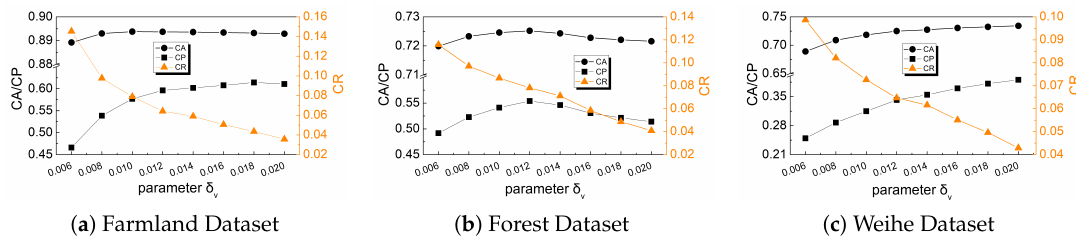
Figure 9. Relationship between parameter δ v and the result of pre-classification.